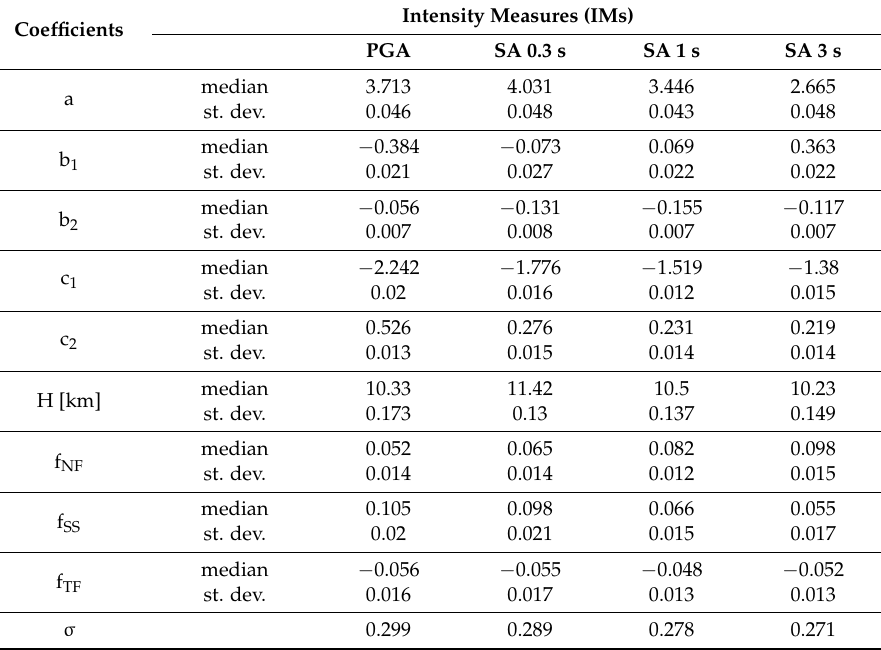
Table 4. Median values and standard deviations of the coefficients of